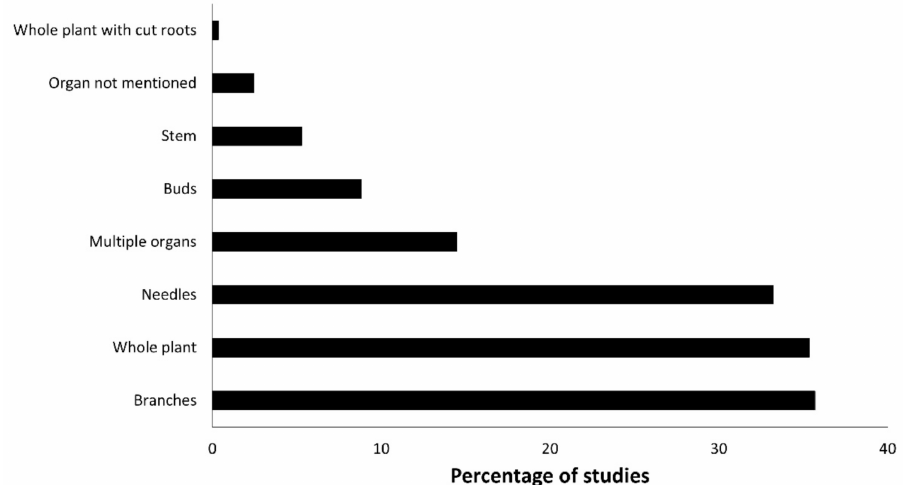
Figure 3. Plant organs studied for frost tolerance ordered by percentage of studies.